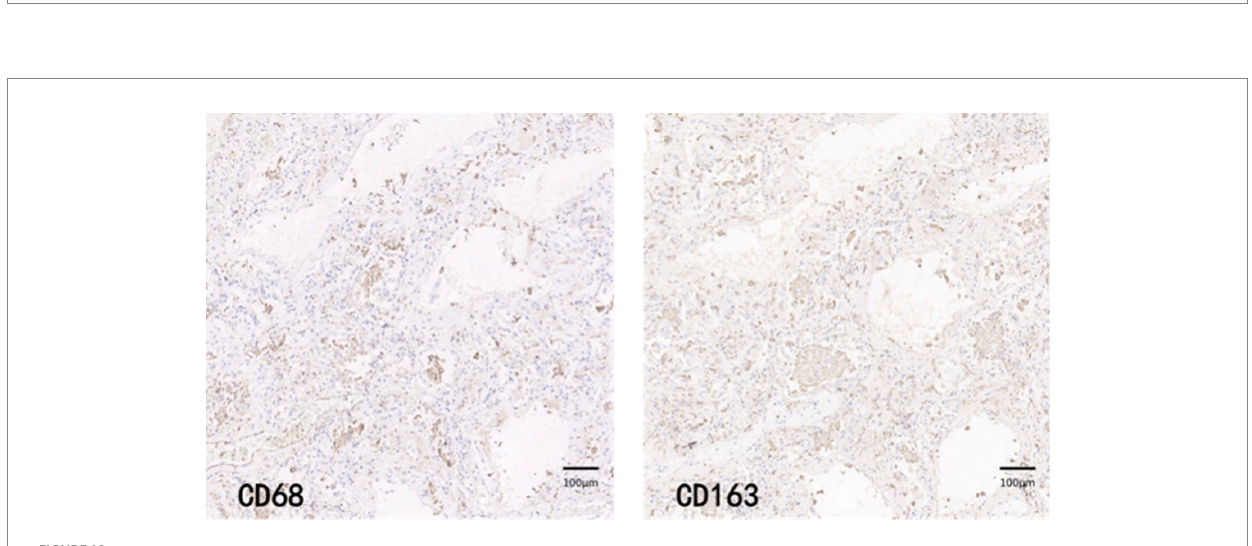
FIGURE 10 COV-M group immunohistochemical staining PATCH (1,600 × 1,600